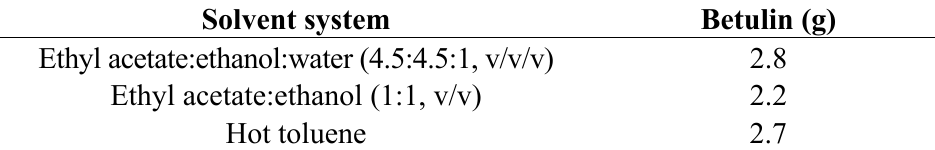
Table 2. Pure betulin obtained from 4 g of white birch bark extract.